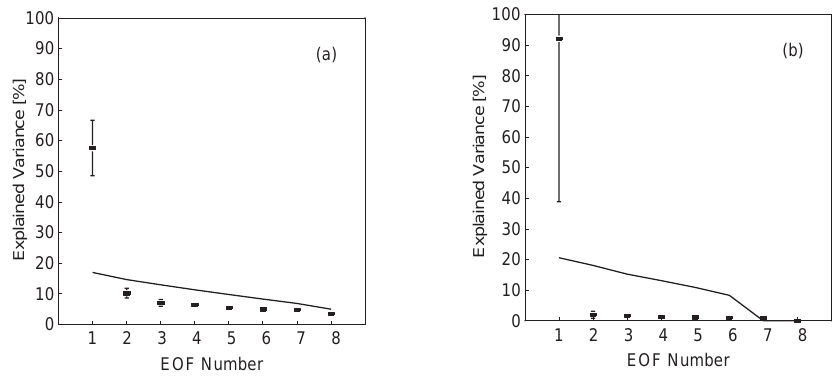
Figure 4. Variance spectrum of the spatial (a) and temporal (b) analysis in the grassland test site. Error bars indicate the 95% confidence interval according to Eq. (6); the solid line represents the significance limit calculated by Monte Carlo simulation.